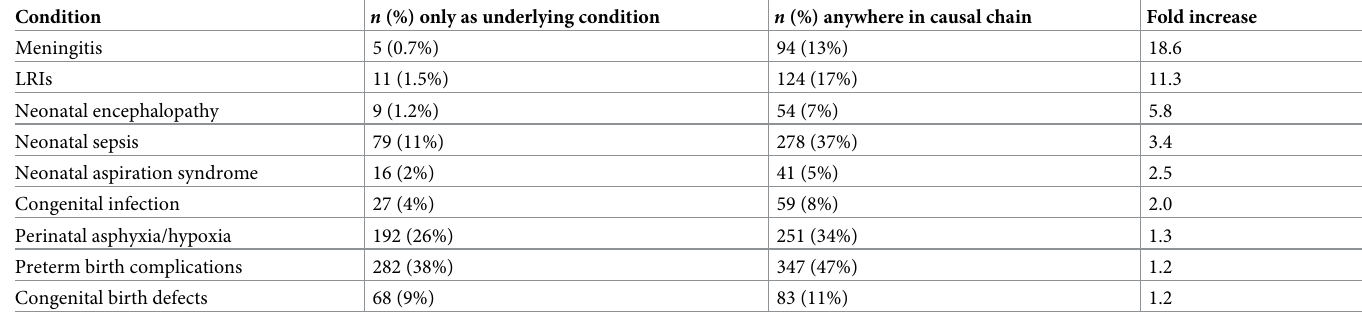
Congenital birth defects CoD, cause of death; LRI, lower respiratory